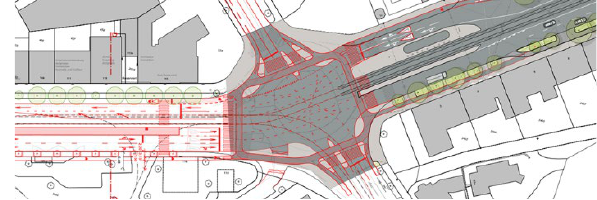
Figure 5. Burgernziel junction drawing of Project variant (Source: Metron AG and Stadt Bern)